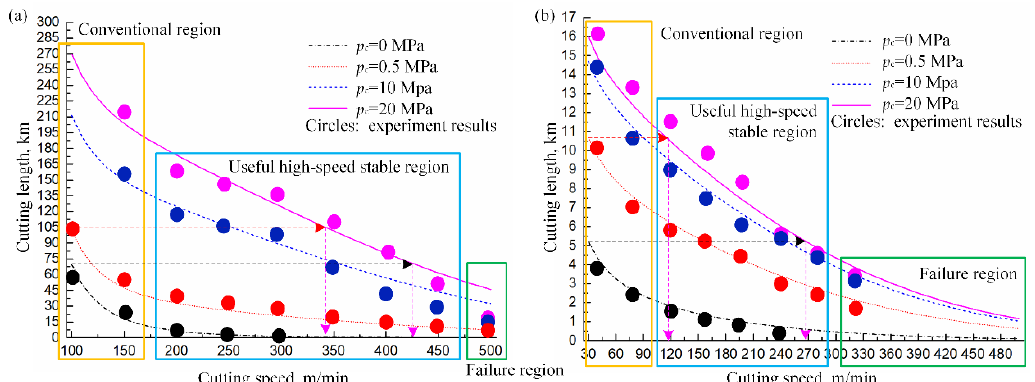
Figure 6. Prediction and experimental tool life values of HUVC versus cutting speed under different cooling pressures, ( a ) Ti alloys, feed per revolution and cutting depth are 0.005 mm/r and 0.05 mm, respectively, and ( b ) Ni alloys, feed per revolution and cutting depth are 0.005 mm/r and 0.2 mm, respectively. The duty cycle is 0.5. p c , cooling pressure.